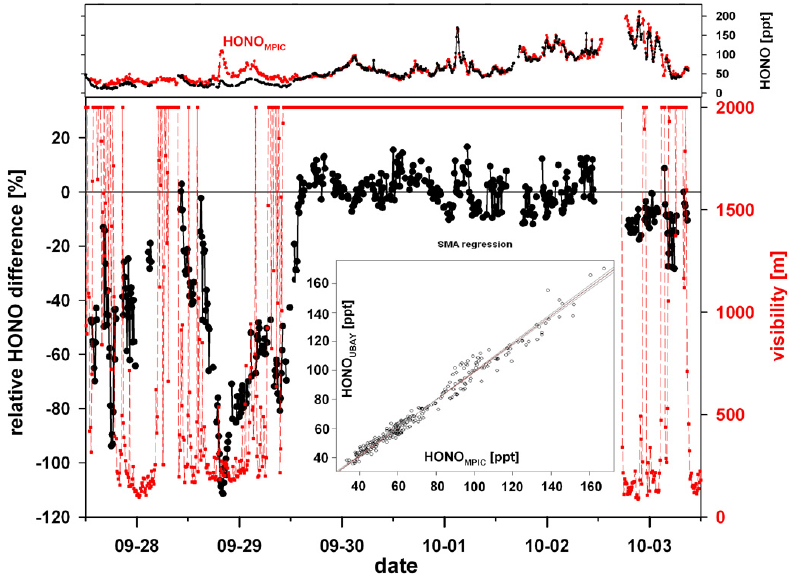
Fig. 1. Side-by-side measurements of the two LOPAP instruments from 27 September (noon) to 3 October 2007 (noon) at the “Waldstein- Weidenbrunnen” research site. Relative differences of the HONO signals (black dots) and visibility range (red squares, dashed lines, maxi- mum range 2000m). The insert shows the regression obtained during dry conditions ( N = 247) from 29 September (14:00CET) to 2 October (10:00CET) using standard major axis (SMA) regression. The upper panel shows the mixing ratios measured by the two LOPAP instruments. Missing values are due to zero air measurements and calibration of the LOPAP